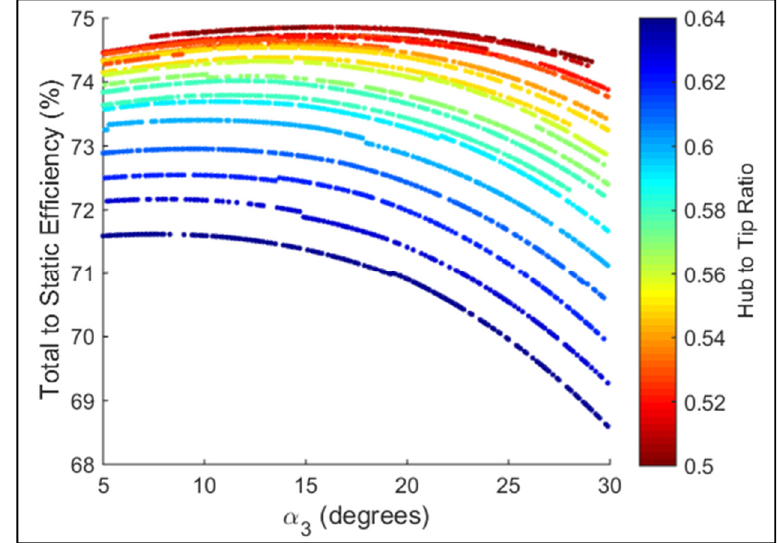
Figure 6. Design space sweep for AR = 0.8, CL = 0.8, (s/c) opt = 0.85, Dmax = 53.43 mm.